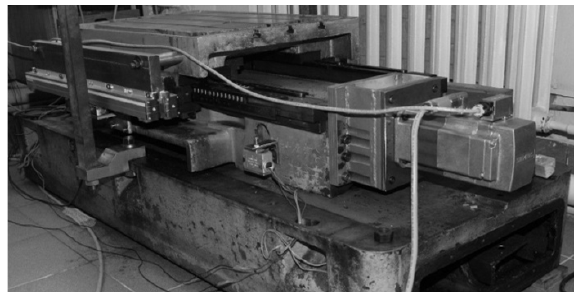
Fig. 4. Model (numbers 1, ..., 7 are the centers of mass of the disks) of the replacing chain